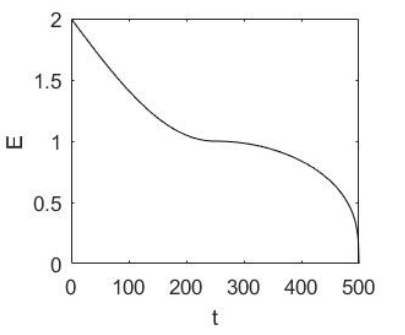
Figure 2. Iterative change graph of E .